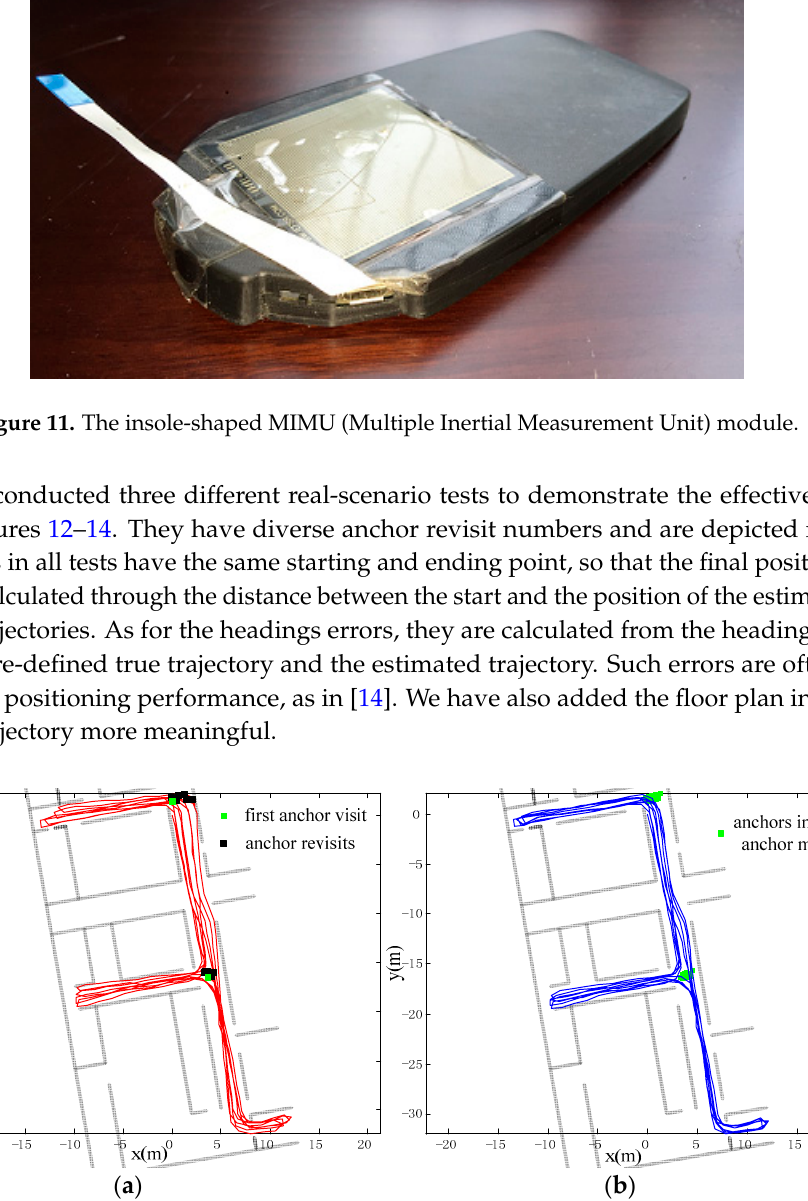
( b ) Figure 13. Test two: Library scenario with few anchor revisits ( a ) Raw trajectory with only one anchor revisit; ( b ) calibrated trajectory with better consistency in the circled area.